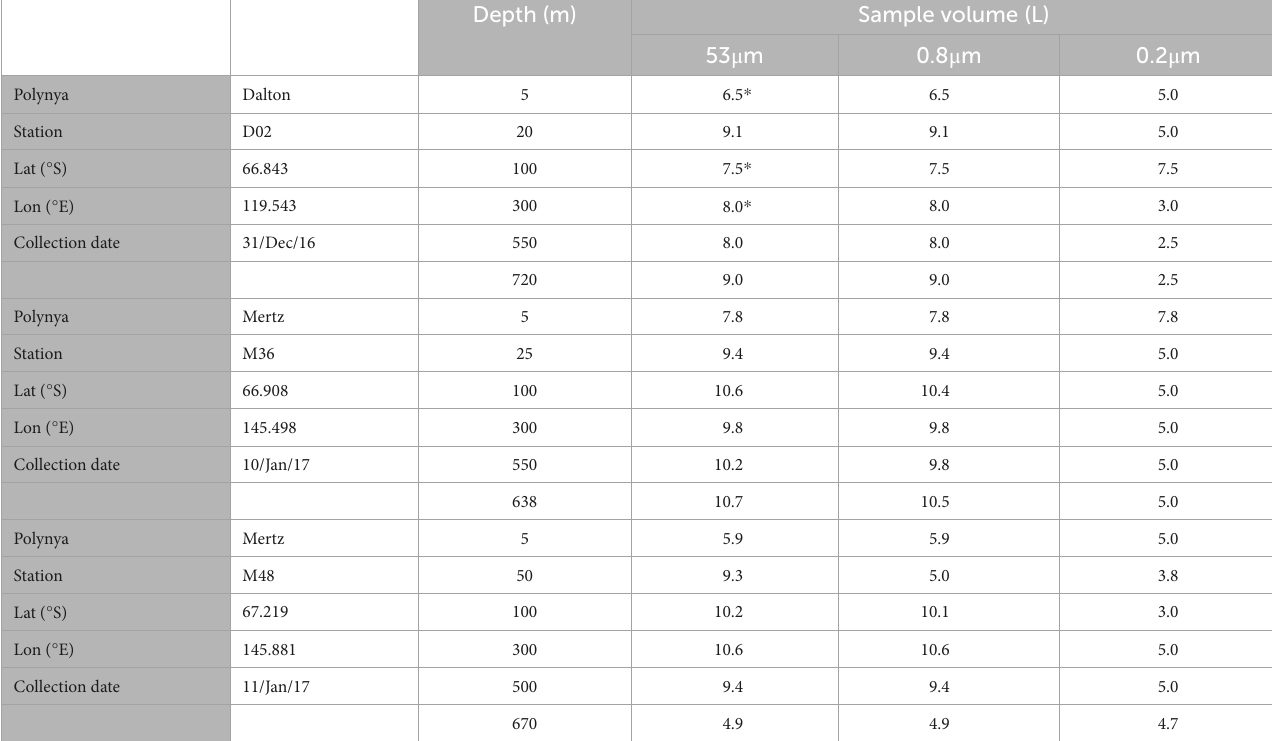
TABLE 1 Characteristics of the sampled sites—location, date, depth, and filtered volume for DNA samples per each